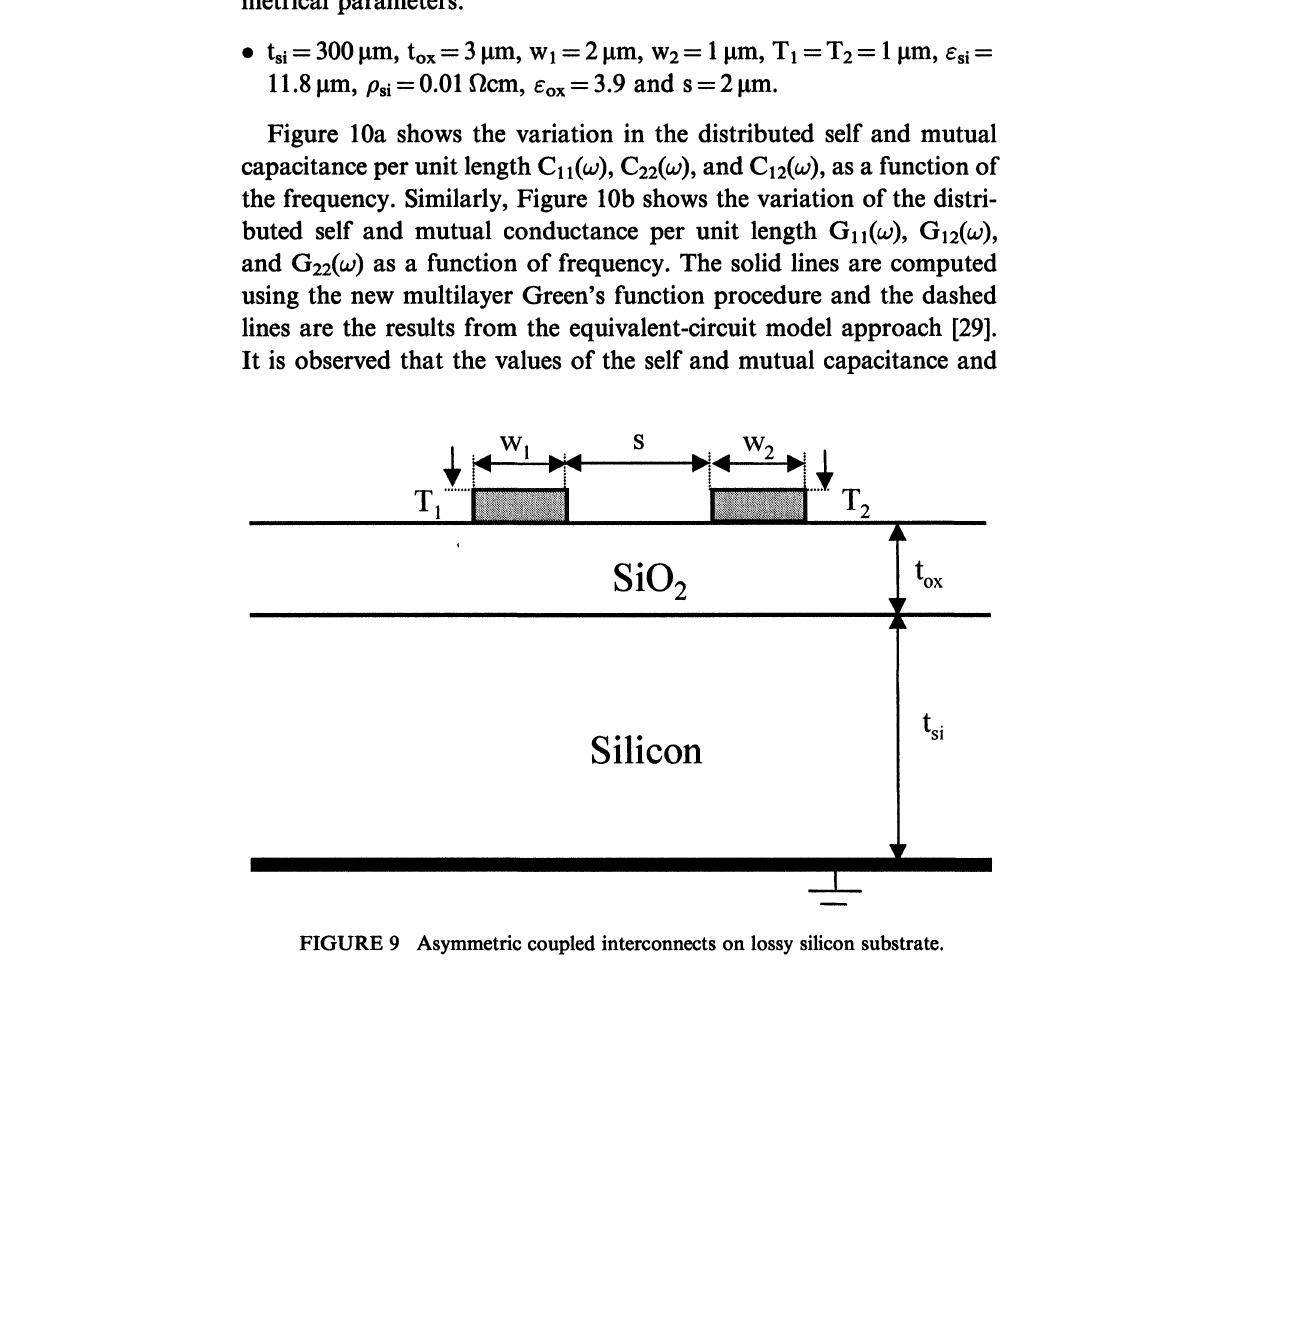
FIGURE 9 Asymmetric coupled interconnects on lossy silicon